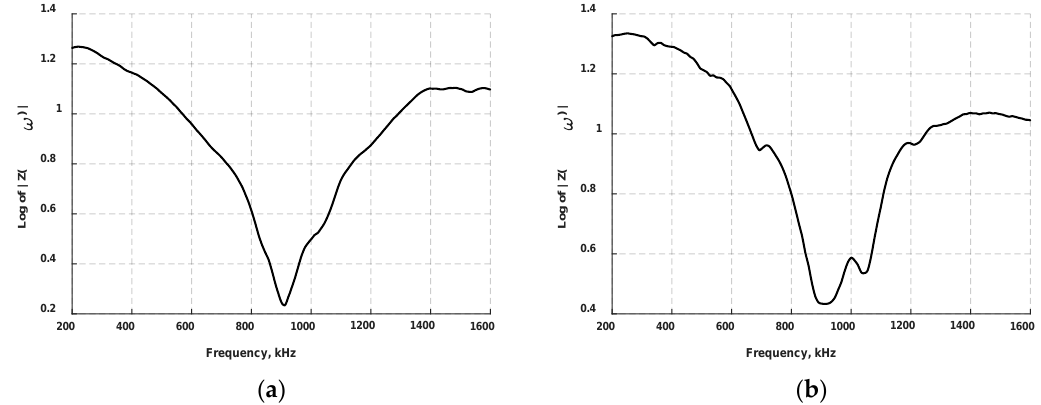
Figure 8. Electromechanical impedance (EMI) response of bondline-embedded d15 PZTs at the pristine state with a frequency range containing the first EM resonance for: ( a ) d15 PZT-1 and ( b ) d15 PZT-2.